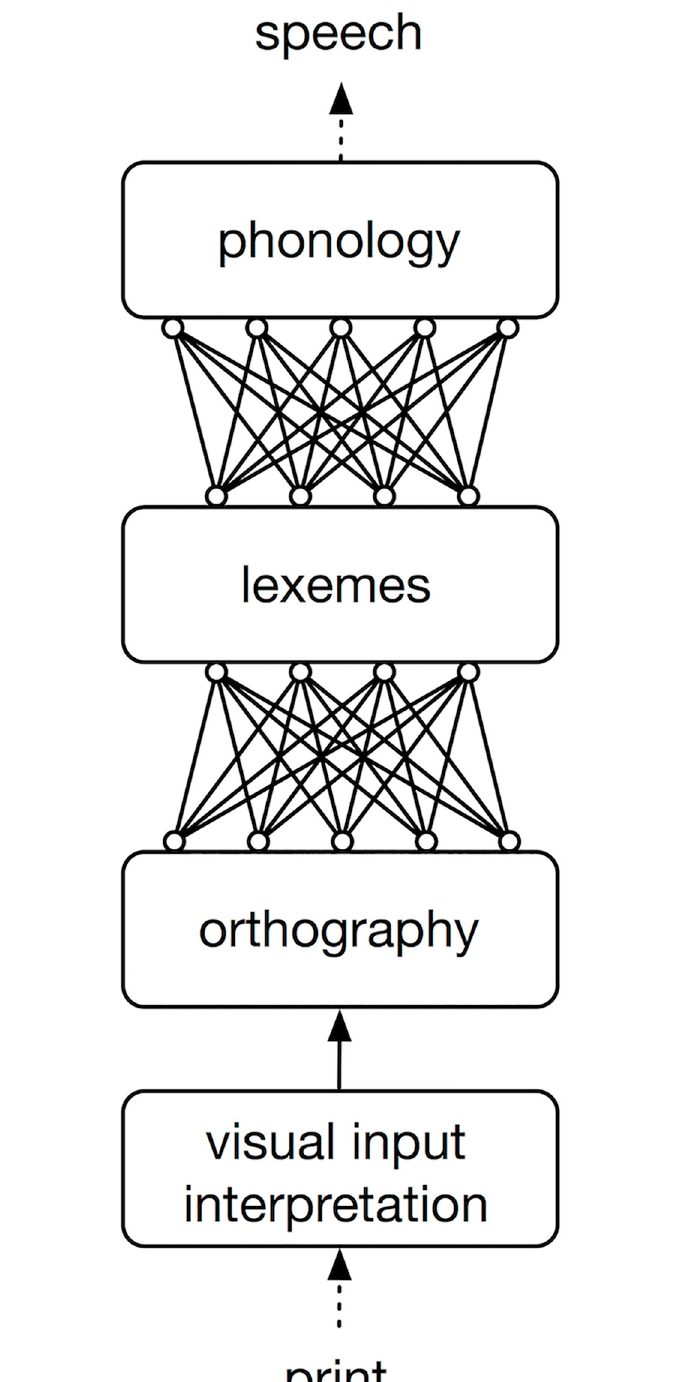
Fig 4. NDR A model. Basic architecture of the Naive Discriminative Reading Aloud (NDR A ) model.